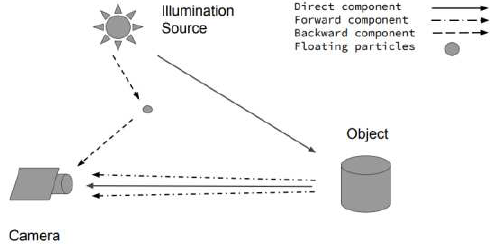
Fig. 1. The 3 elements of underwater image processing: i) the direct component (represented by a dash-dot line) ii) the forward component (represented by a straight line) and iii) the backward scatter component (represented by a dashed line) As the images taken in underwater environment is mainly dominated by blue colour, we will be making use of a Colour Balancing Technique.